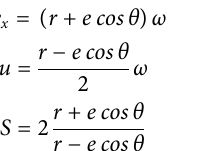
clockwise at 60 rpm. Preloads of 35 and 70 N have been applied for the circular eccentric and the spline cam respectively, with the contact on the base circle (points with z (cid:3) 0). A spring with a stiffness of 20.22 N/mm was used. Single cycles, extracted from the recorded data, have been deeply analyzed. Sample results related to single cycles are reported and discussed in the following section for each one of the two cams tested at 6 and 60 rpm.